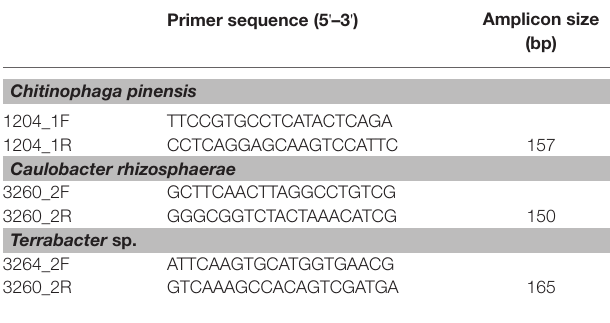
TABLE 1 | Primer pairs used to amplify the three bacterial